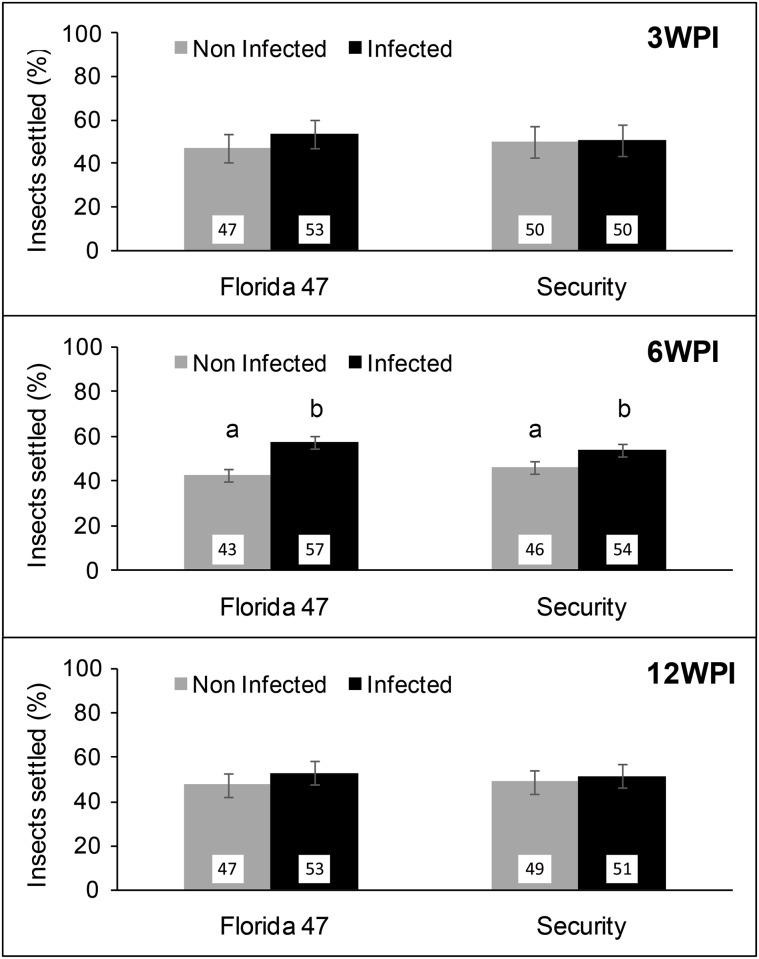
Settling of non-viruliferous whiteflies (B. tabaci).Bars with standard errors indicate percent settling of non-viruliferous adult whiteflies on TYLCV-infected (black bars) or non-infected (grey bars) leaves of a TYLCV-resistant (Security) and a susceptible (Florida 47) genotype 24h post release. Panels show whitefly settling on infected and non-infected plants after 3, 6, and 12 weeks post inoculation, respectively. Different letters indicate significant differences between treatments at α = 0.05 based on least square means.